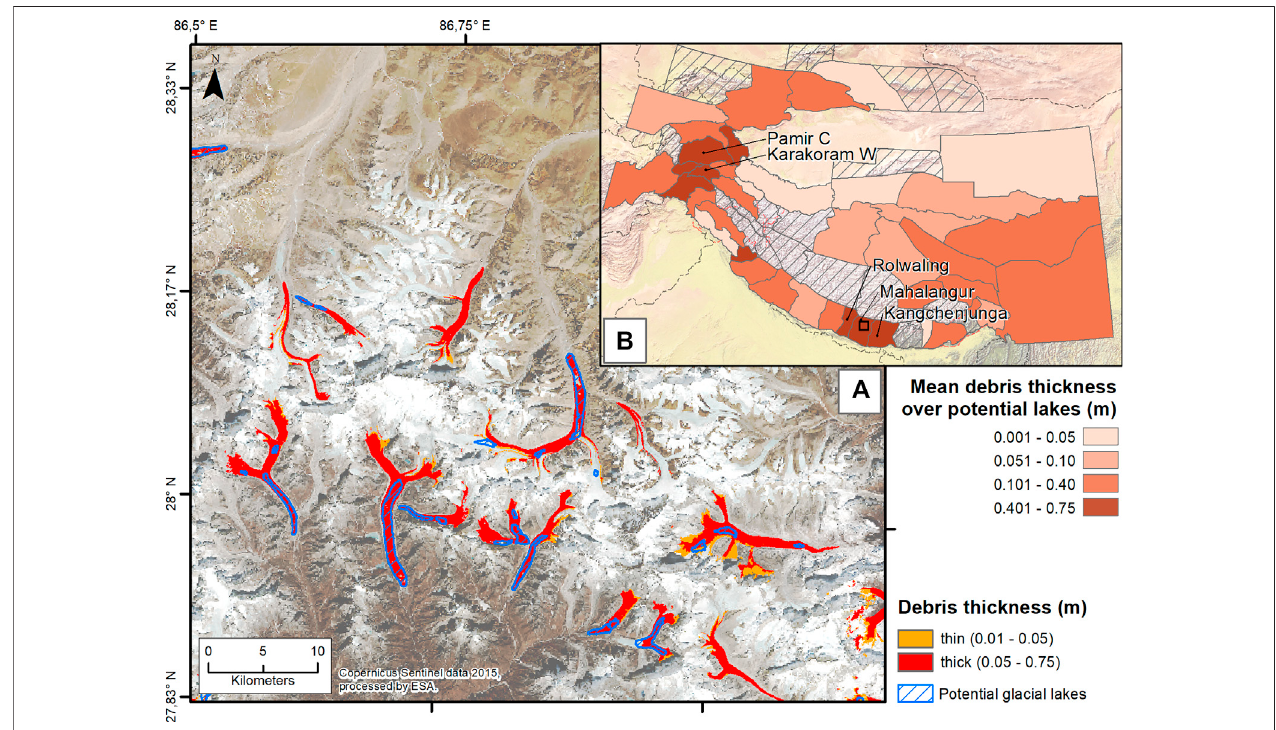
FIGURE8| GlacierdebriscoverinMahalanguratthepotentiallocationsoffuturelakes (A) andthemeandebristhicknessoverlakelocationsinentireHMA (B) .The small black rectangle in B indicates the extent of (A) . The debris cover dataset is provided by Rounce et al. (2021), although some regions in (B) are excluded due to insuf fi cient debris cover data (hatched